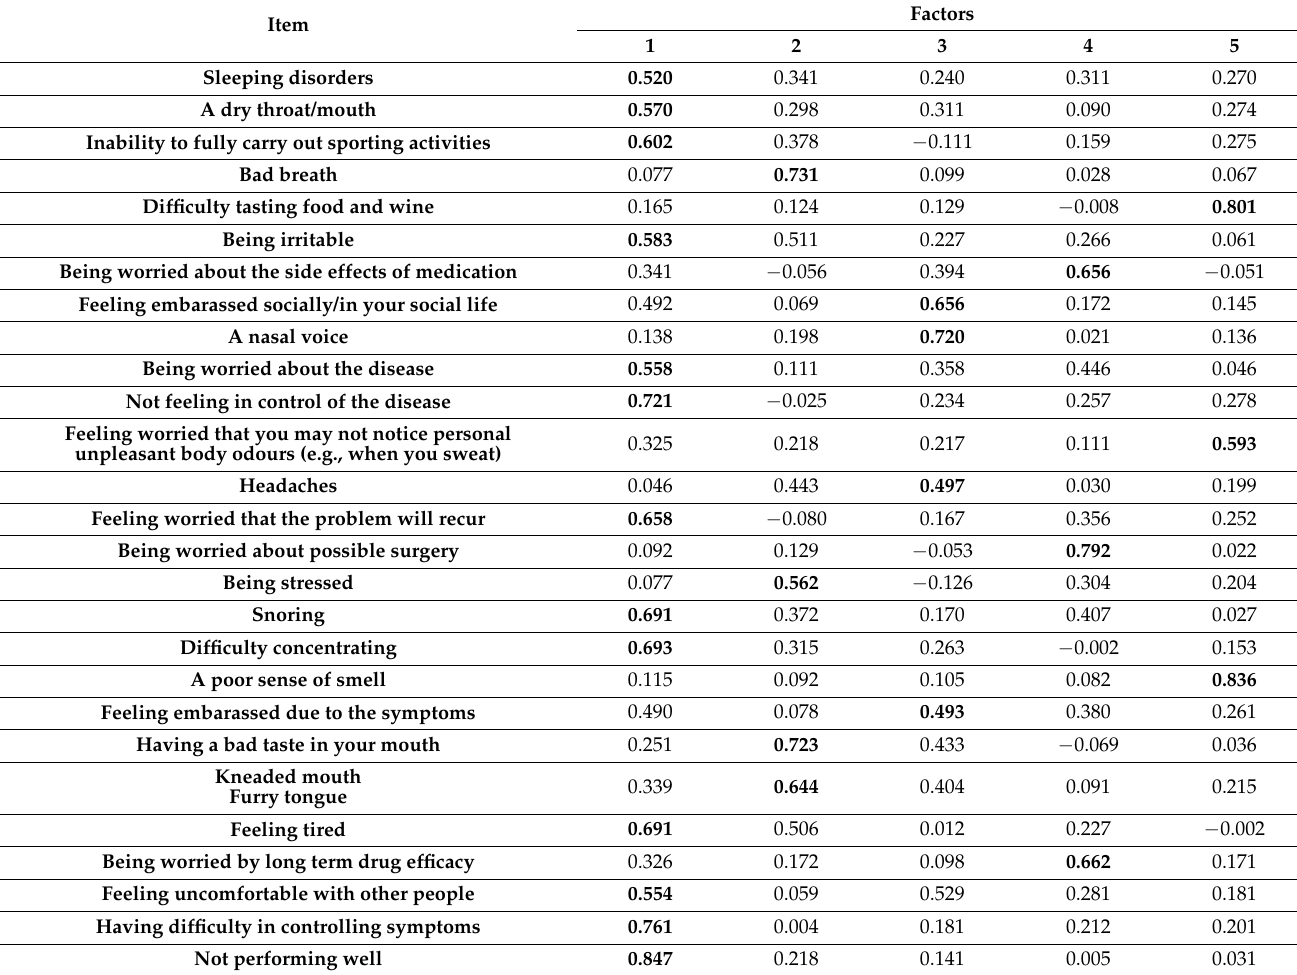
Table 2. Factors identified using principal components analysis on full data set: 1—Daily life impact;